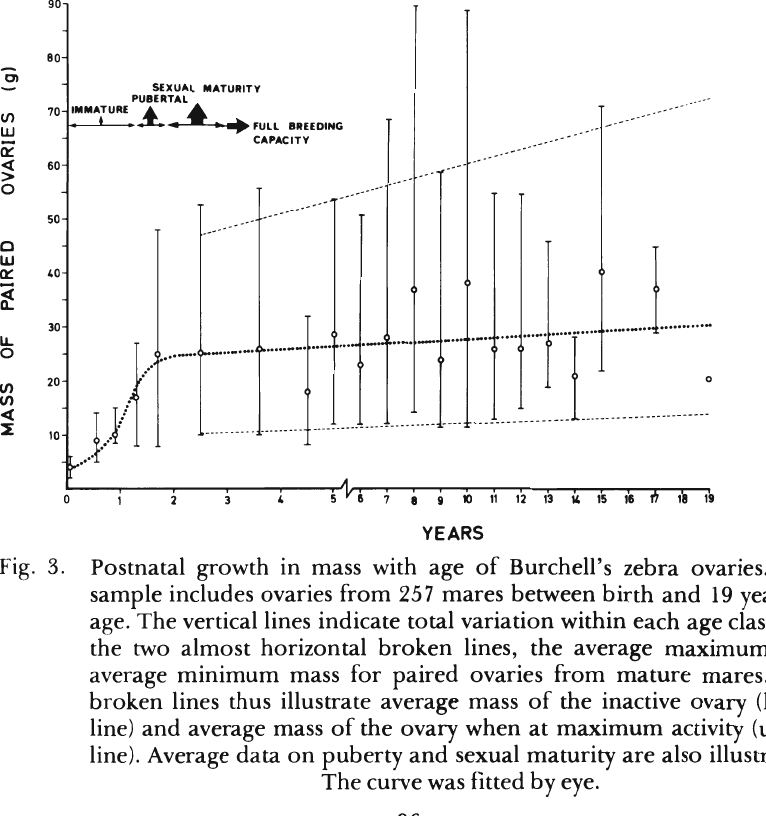
Fig. 2. Growth in mass with age of foetal gonads from Burchell's zebra. (n = 43 pairs of foetal ovaries and 41 pairs of foetal testes). The curve was litted by eye.